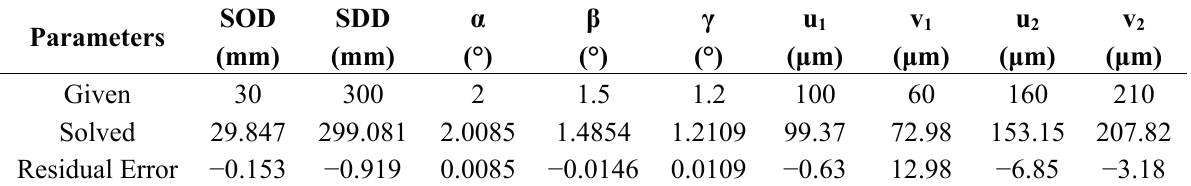
Table 3. Simulation results with errors in extracting